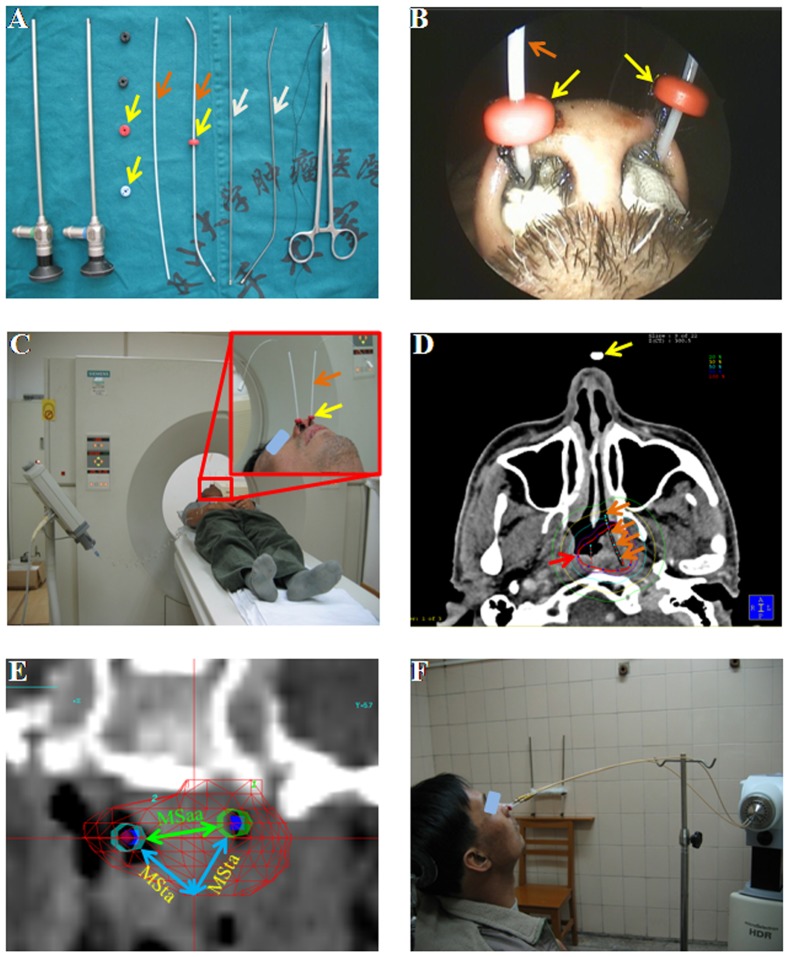
Endoscopic-guided IMBT boost administration process.(A) The instruments and applicators used in endoscopic-guided IMBT boost process. (B) The nasal outward view of applicators sewed to the nose wings. (C) CT scan of the tumor and applicators location. (D) CT images of tumor residue, applicators and isodose line. The red arrow indicated the 100% isodose curve covering the whole GTV. (E) The 3-dimensional reconstruction image of two applicators (outlined by hepta-prism) inserting into the nasopharyngeal residue (outlined by red fine grid lines) in coronal section. MSta was referred to the maximum spacing from the tumor margin to the nearest applicator (blue arrows), and MSaa was referred to minimum distance between two applicators (green arrow). (F) A representative case that was delivering the IMBT boost. The crimson arrow denoted the applicator outline, and white arrow displayed the 6F sharp Obturator with 0 and 30 degree angle. The yellow arrow indicated the Radio Opaque Button.